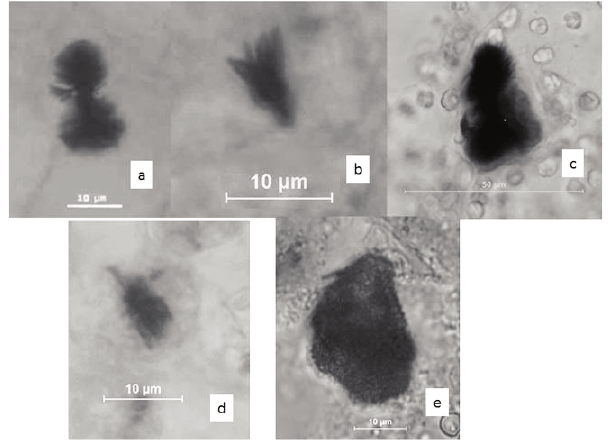
Fig. 3 - Dark red crystals from the leaves of treated plants after ferric acid reaction: A) from cultivar Draga; B) from culti- var Spunta; C-D) Naringin crystals with melted edges after boiling in water: C) from cultivar Draga; D) from cul- tivar Spunta, E) from grapefruit juice.